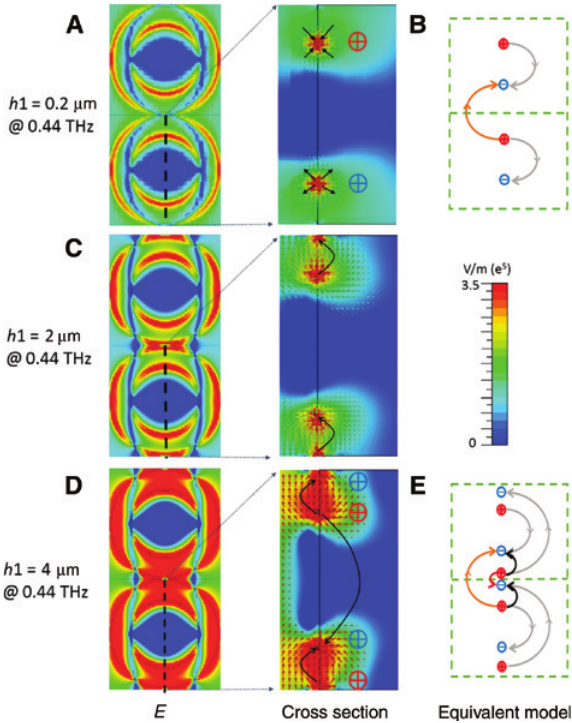
Figure 4: (A, C, D) Electric field distribution and cross-sectional field distribution along the Y direction at 0.44 THz with h 1 = 0.2 μ m, h 1 = 2 μ m and h 1 = 4 μ m, respectively. (B, E) The dipole model at h 1 = 0.2 μ m and h 1 = 4 μ m, respectively.